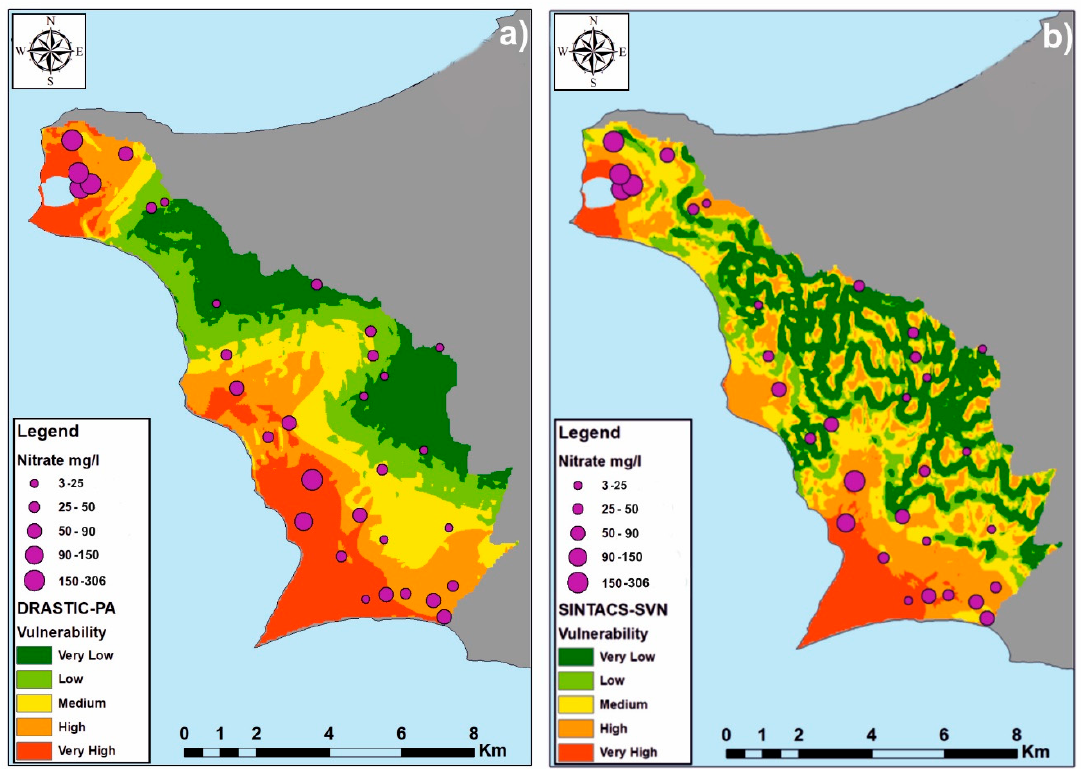
Figure 4. ( a ) DRASTIC-PA application and ( b ) SINTACS-SVN for Epanomi coastal